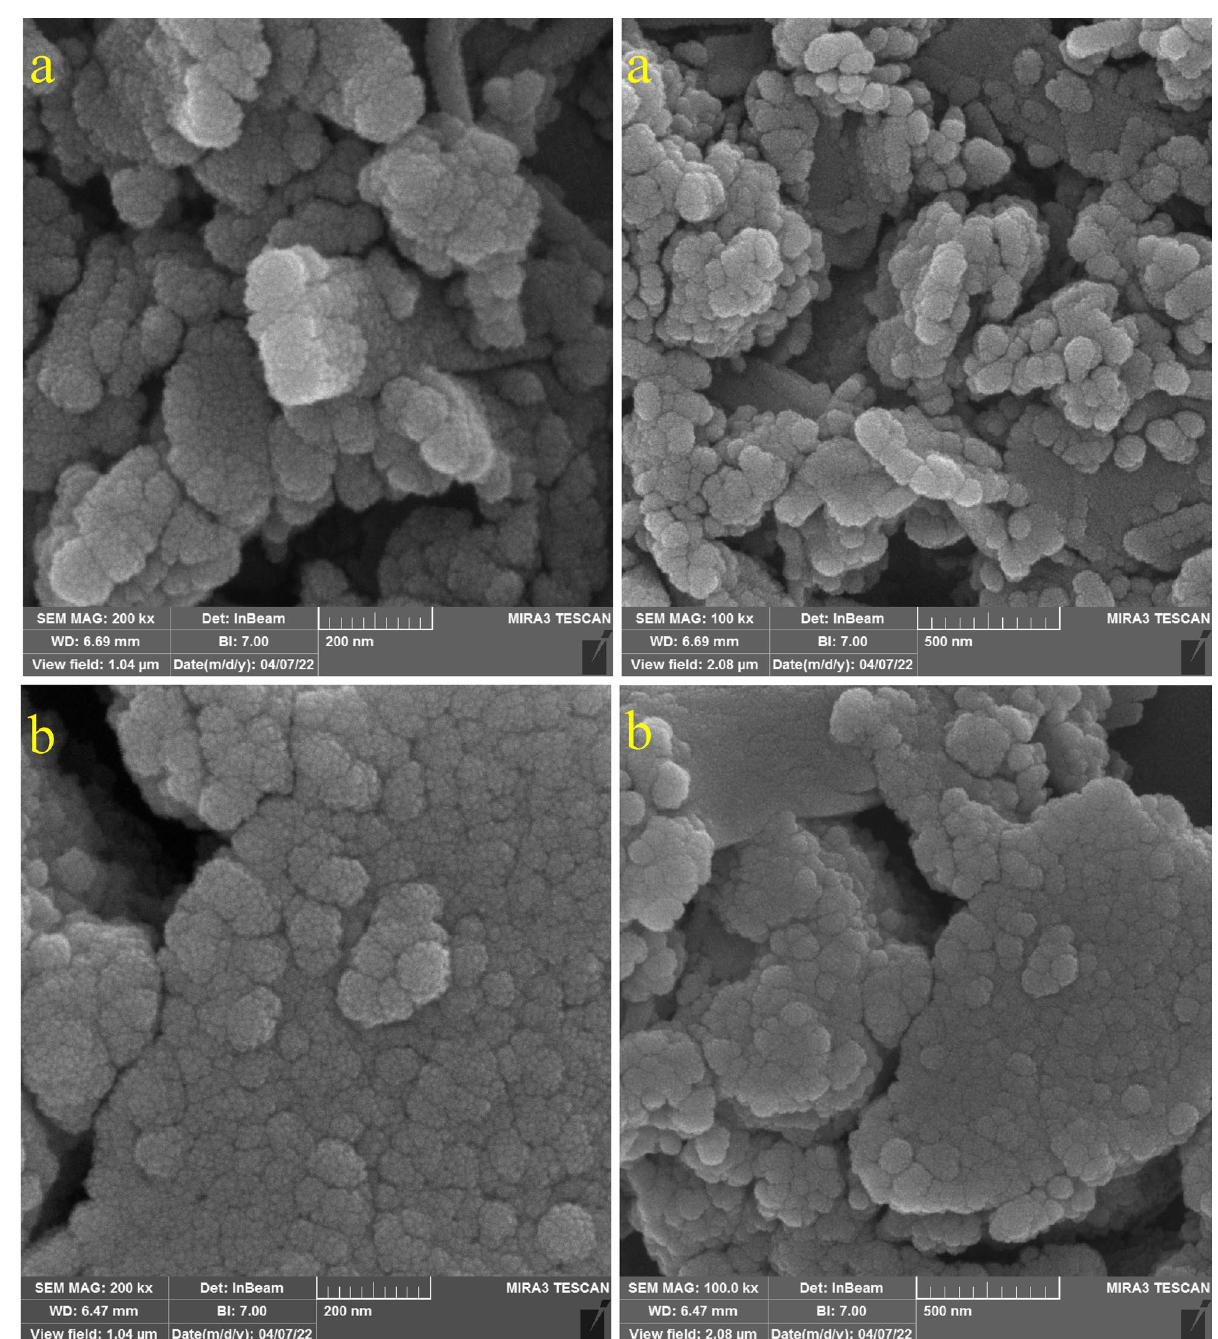
Figure 2. SEM image of ( a ) Cu(II)-MP-bis(AMP)@boehmite and ( b )